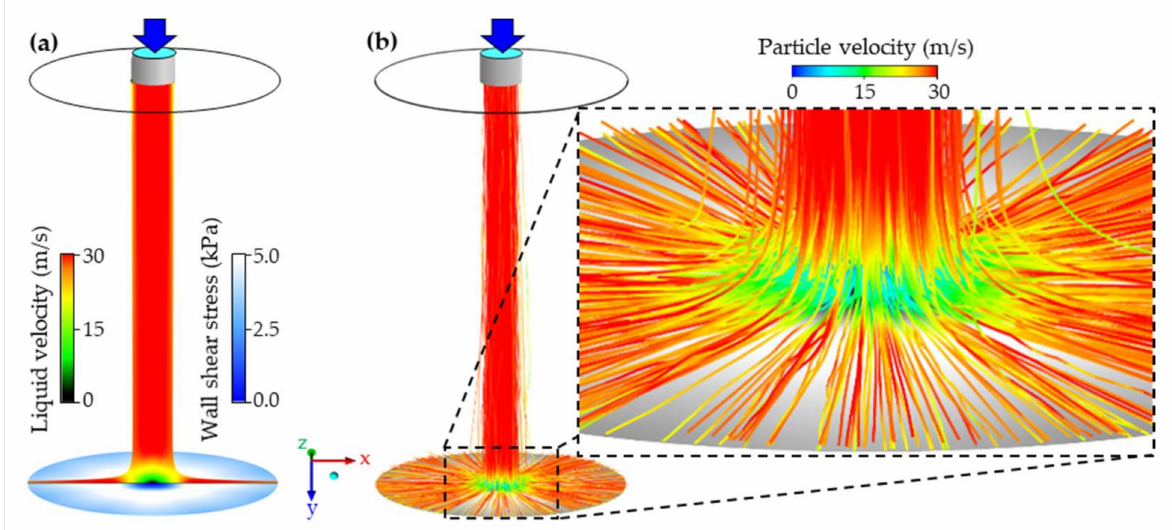
Figure 17. Numerical results of ( a ) liquid velocity field and the wall shear stress, and ( b ) particle trajectories and particle velocity.